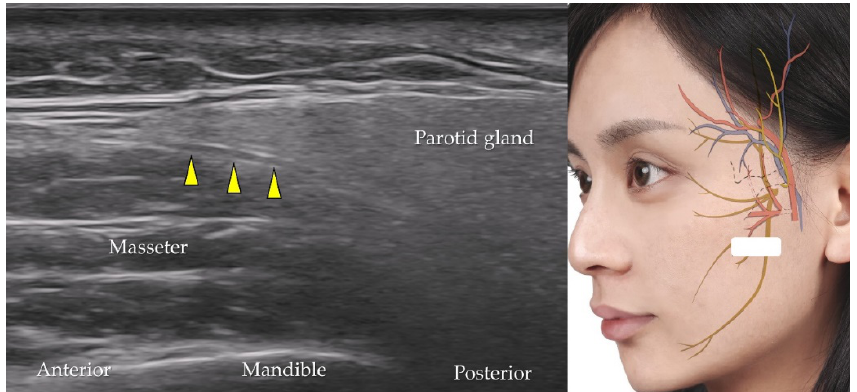
Figure 17. Ultrasound imaging of the facial nerve ( yellow arrowheads ). White square , the footprint of the ultrasound transducer. Table 2. Summary of the anatomy and scanning techniques for the neurovascular structures over the middle face.